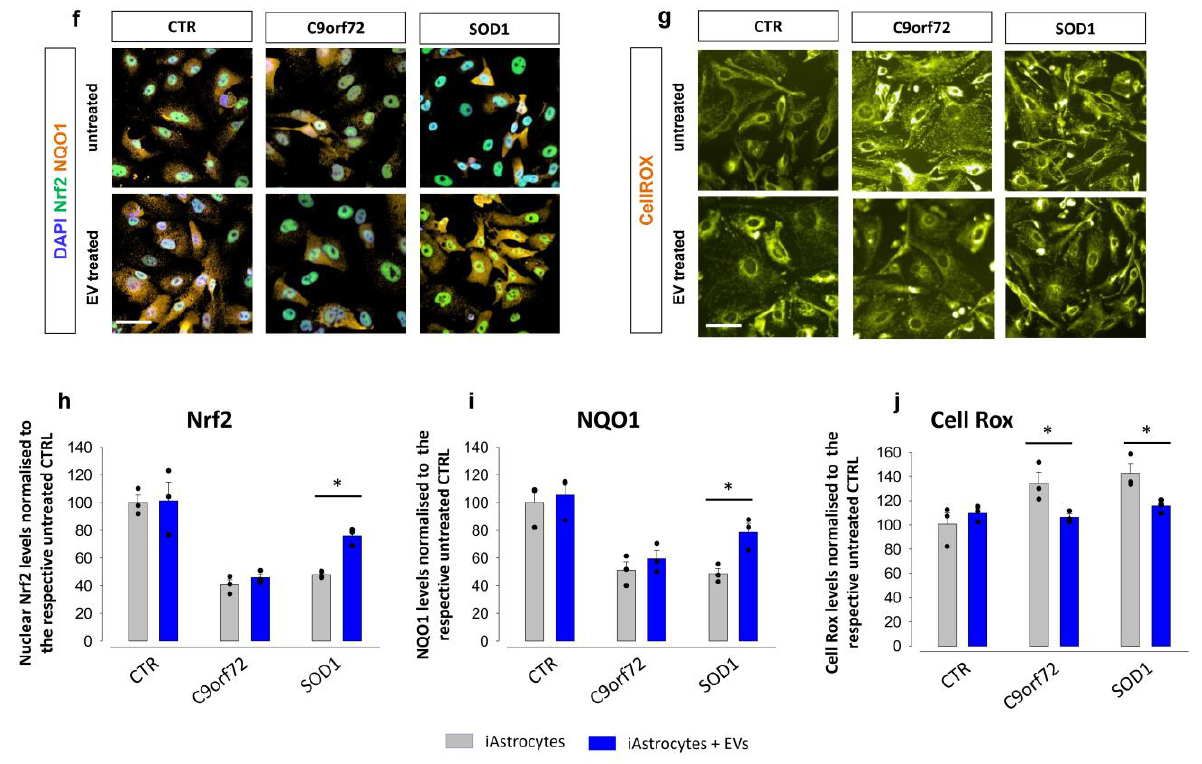
Figure 5. MSc-derived EVs positively modulate the Nrf2-NQO1 antioxidant pathway in mouse SOD1 G93A and patient-derived astrocytes. ( a – e ) Effect of MSC-derived EVs on oxidative stress in mouse SOD1 G93A astrocytes. ( a ) Representative WB images for Nrf2 and NQO1 in WT astrocytes, SOD1 G93A astrocytes and EV-treated SOD1 G93A astrocytes. ( b , c ) Quantitative analyses of WB experi- ments for Nrf2 and NQO1. Data are presented as means ± SEM of n = 3–4 (referred to Nrf2) and n = 3–5 (referred to NQO1) independent experiments, run in triplicate; statistical significance for p < 0.05 (* p < 0.05 vs. WT; Nrf2 F (2,8) = 5.307; NQO1 F (2,9) = 0.716; one-way ANOVA, followed by Bon- ferroni post hoc test). ( d ) Representative confocal microscopy images for GAPDH (red fluorescence), Nrf2 (green fluorescence) and DAPI (blue fluorescence), in WT, SOD1 G93A astrocytes and EV-treated SOD1 G93A astrocytes. Scale bar: 100 µ m. ( e ) Quantitative representation of fluorescence intensity related to the nucleus/cytosol cellular localization ratio. Data are presented as means ± SEM of n = 3–5 independent experiments, run in triplicate; statistical significance for p < 0.05 (* p < 0.001 vs. WT; # p < 0.001 vs. untreated SOD1 G93A astrocytes; F (2,6) = 307.883; one-way ANOVA, followed by Bonferroni post hoc test). ( f – j ) Effect of MSC-derived EVs in human iAstrocytes. ( f ) Represen- tative immunofluorescence images of Nrf2 (green fluorescence) and NQO1 (orange fluorescence) in untreated iAstrocytes and iAstrocytes exposed to human MSC-derived EVs. Scale bar: 100 µ m. ( g ) Representative immunofluorescence images of reactive oxygen species stained with CellROX ® probe (orange fluorescence) in controls (CTR), untreated iAstrocytes and iAstrocytes exposed to human MSC-derived EVs. Scale bar: 100 µ m. ( h ) Quantification of fluorescence for total Nrf2 expres- sion in controls (CTR), C9orf72, and SOD1 patients, treated or not with human MSC-derived EVs. ( i ) Quantification of fluorescence for total NQO1 expression. Data are expressed as means ± SEM of n = 3 independent experiments. Statistical significance for p < 0.05 (* p < 0.05 vs. untreated iAstrocytes; F (2,17) = 42.335 for Nrf2; F (2,17) = 26.163 for NQO1; two-way ANOVA with Sidak’s multi comparison test). ( j ) Quantitative analyses of reactive oxygen species stained with CellROX ® probe, in controls (CTR), C9orf72, and SOD1 patients treated or not with EVs. Data are expressed as means ± SEM, n = 3 independent experiments, including two technical replicates per experiment. Statistical signifi- cance for p < 0.05 (* p < 0.05 vs. untreated iAstrocytes; F (2,17) = 6.605; two-way ANOVA with Sidak’s multi comparison